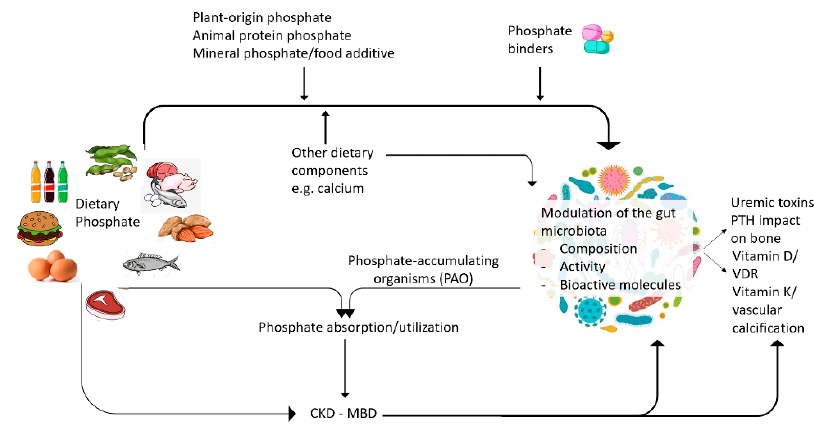
Figure 2. Phosphate-accumulating organisms (PAOs) to prevent positive phosphate balance in CKD.